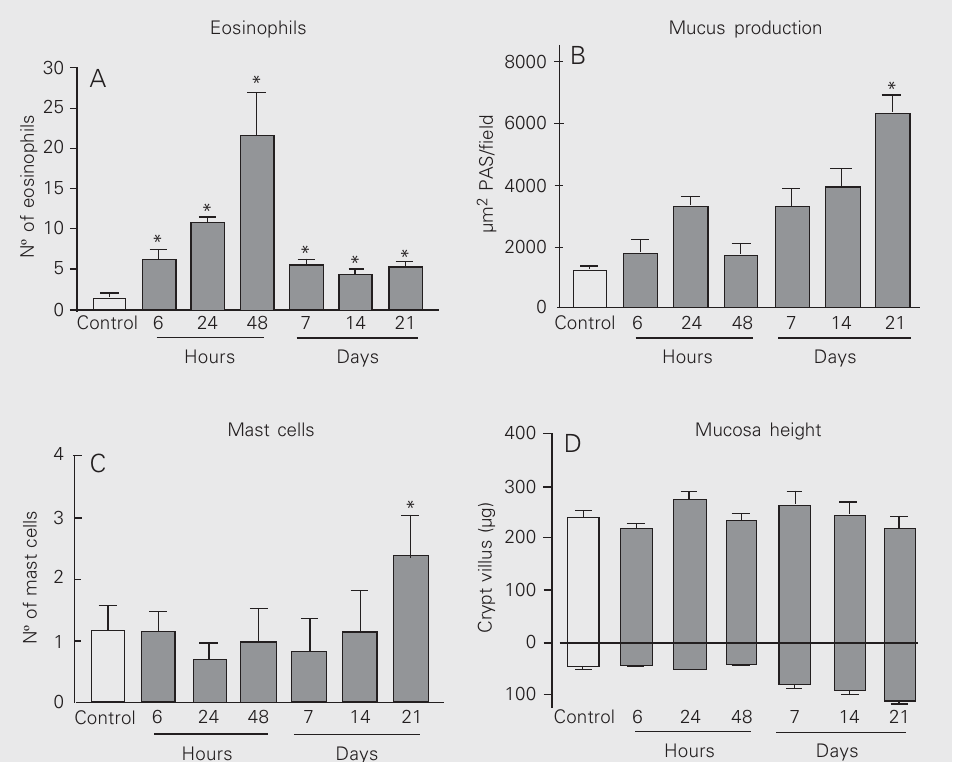
Figure 4. Representa- tive histological sec- tions of the proximal jejunum from non-sen- sitized mice drinking water (A), and from sensitized mice after 24 h (B), 48 h (C) and 21 days (D, E) of con- tinuous ingestion of a filtered 20% egg white solution. A, B and D, hematoxylin and eosin staining; C, chromo- trope 2R staining; E, Toluidine blue staining. The bars are 50 µm in A, B, D and E, and the bar in C is 25 µm. The